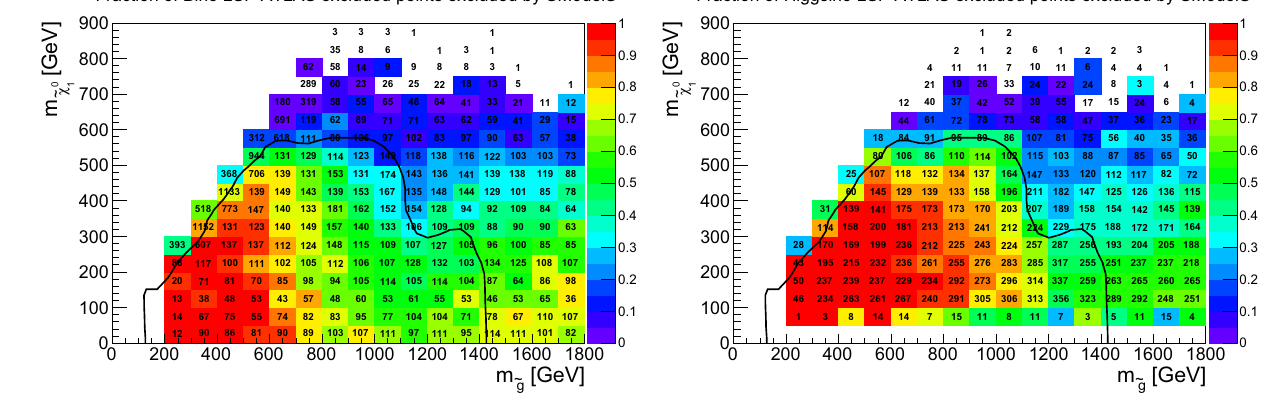
Fraction of Bino LSP ATLAS excluded points excluded by SModelS